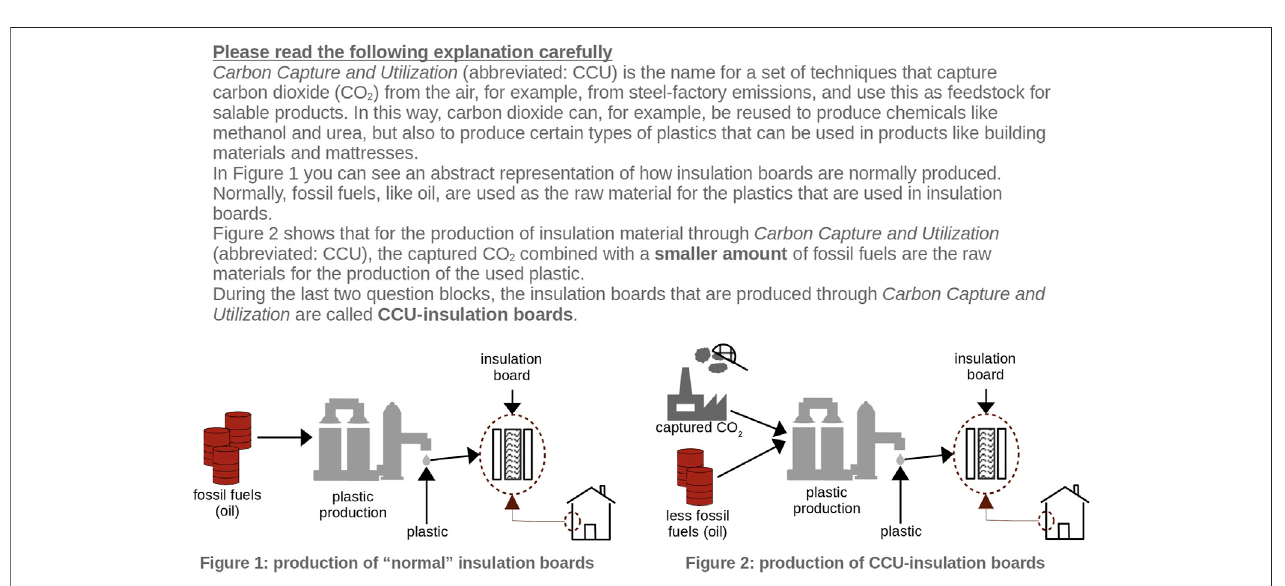
FIGURE 2 | The English translation of the explanation on CCU that was provided in the